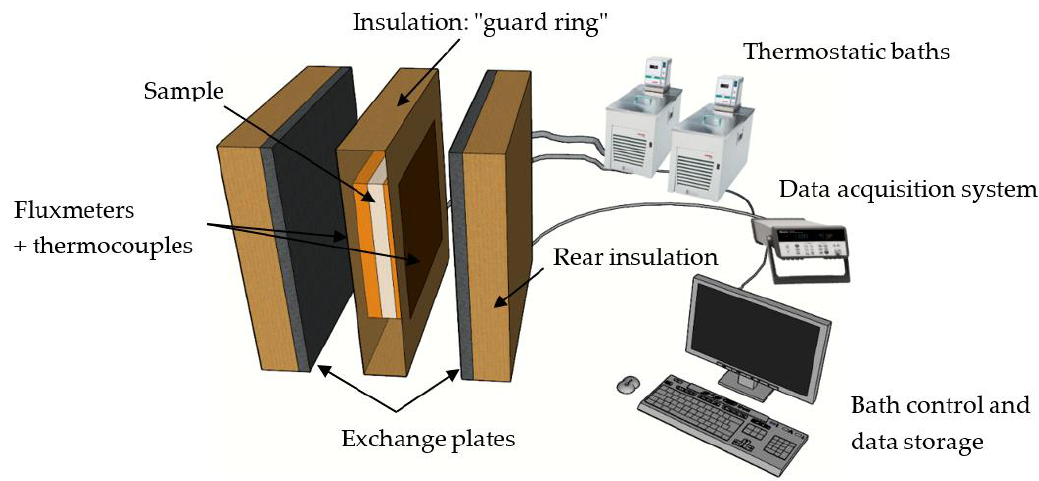
Figure 4. Experimental apparatus.